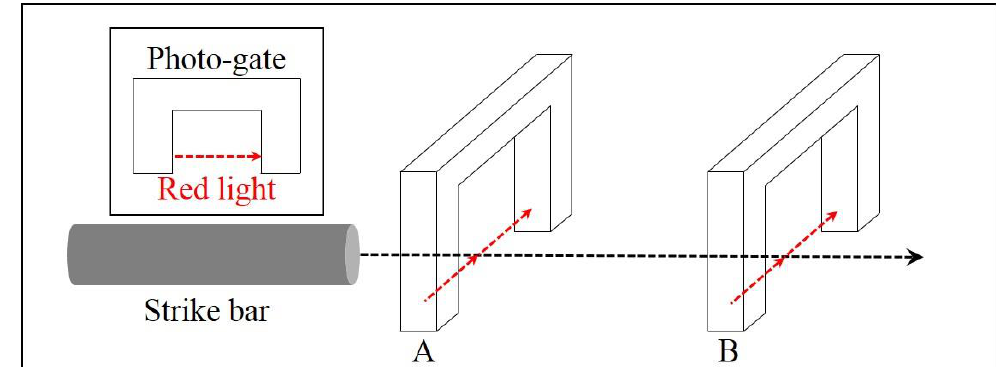
Figure 23. Schematic illustration of photogate mechanism.